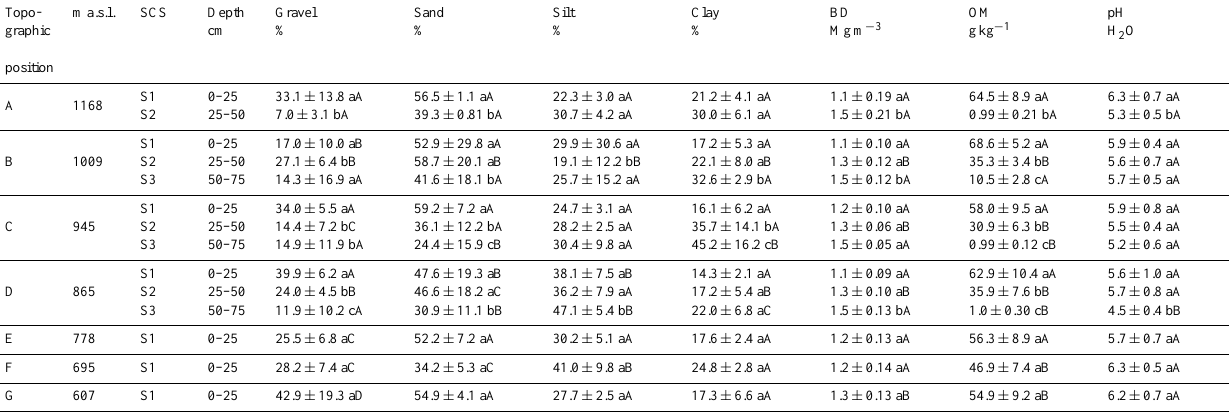
ma.s.l.:metersabovesealevel;SCS:soilcontrolsection;BD:bulkdensity;OM:organicmatter. ∗ Standarddeviation.Numbersfollowedbydifferentlower-caseletterswithinthesamecolumnhavesignificantdifferences( P <0.05)atdifferentdepths,considering thesametopographicposition.Numbersfollowedbydifferentcapitalletterswithinthesamecolumnhavesignificantdifferences( P